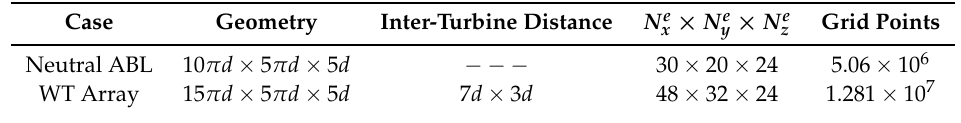
Table 1. Details of the computational grids for the precursor ABL and the wind turbine array domain. N e η is the number of spectral elements in the η direction. Eight Gauss-Lobatto-Legendre (GLL) nodes (Legendre polynomial order 7) have been used per element per Cartesian direction.